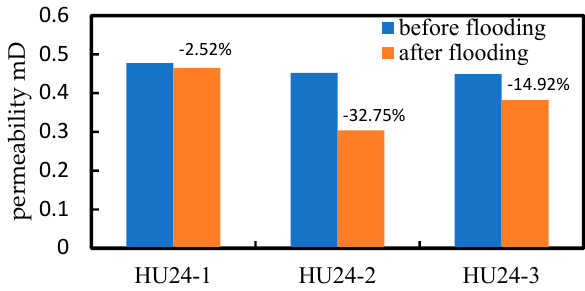
Figure 4. Core permeability before and after the flooding experiments.